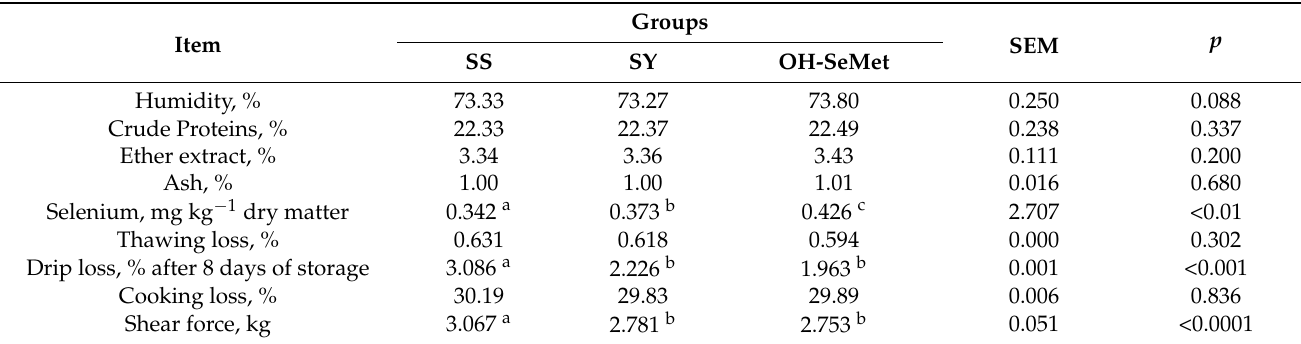
Table 3. Least square means pertaining to the effect of the selenium source during the finishing phase on the chemical composition, selenium content, shear force, thawing, drip, and cooking losses of the meat.